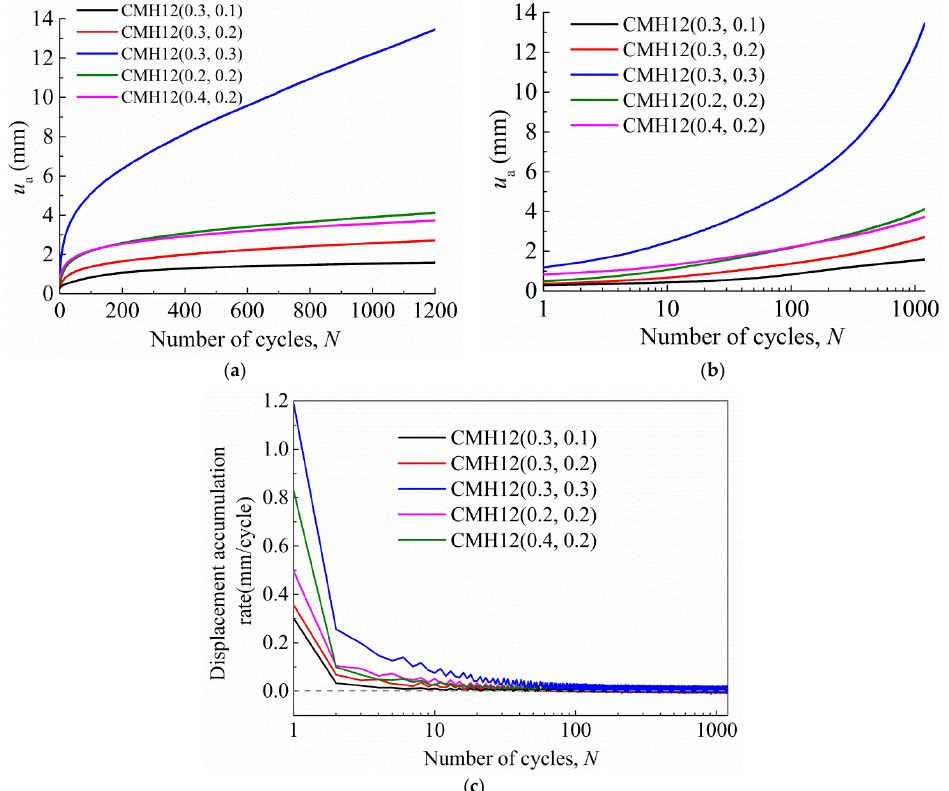
Figure 19. Developments of accumulated displacement and displacement accumulation rates under different cyclic parameters: ( a ) linear scale of u a - N; ( b ) semi-log scale of u a - N; ( c ) semi-log scale of displacement accumulation rate- N.